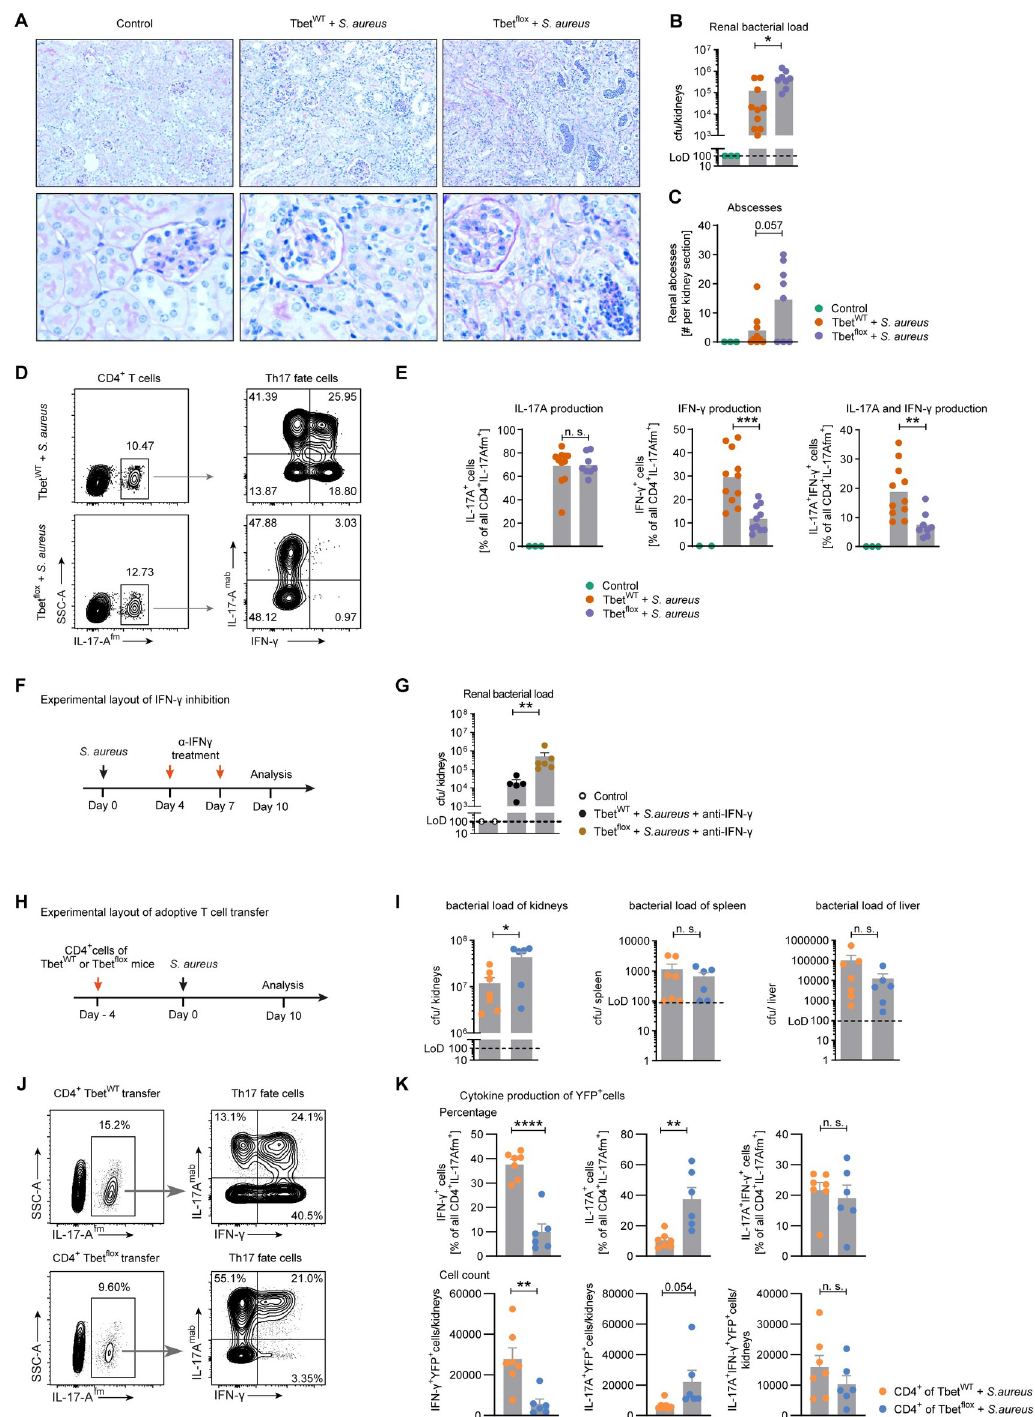
Fig 6. Tbx21 expressing renal Th17 cells drive bacterial clearance in the kidney. (A) Abscess formation in PAS staining of kidney sections in control mice and 10 days after S . aureus infection in Th17 fate reporter mice ( Il17aCre x R26eYFP ) and T-bet- deficient fate reporter mice ( Il17aCre x R26eYFP x Tbx21-flox ). (B) Quantification of abscesses per stained kidney section 10 days after S . aureus infection; bars representing mean, individual mice displayed by dots in Dunnett’s multiple comparison one-way ANOVA analysis. (C) Quantification of bacterial load 10 days after S . aureus infection; bars representing mean individual mice displayed by dots, � p < 0.05 in Dunnett’s multiple comparison one-way ANOVA analysis. (D) Flow cytometry of renal YFP +